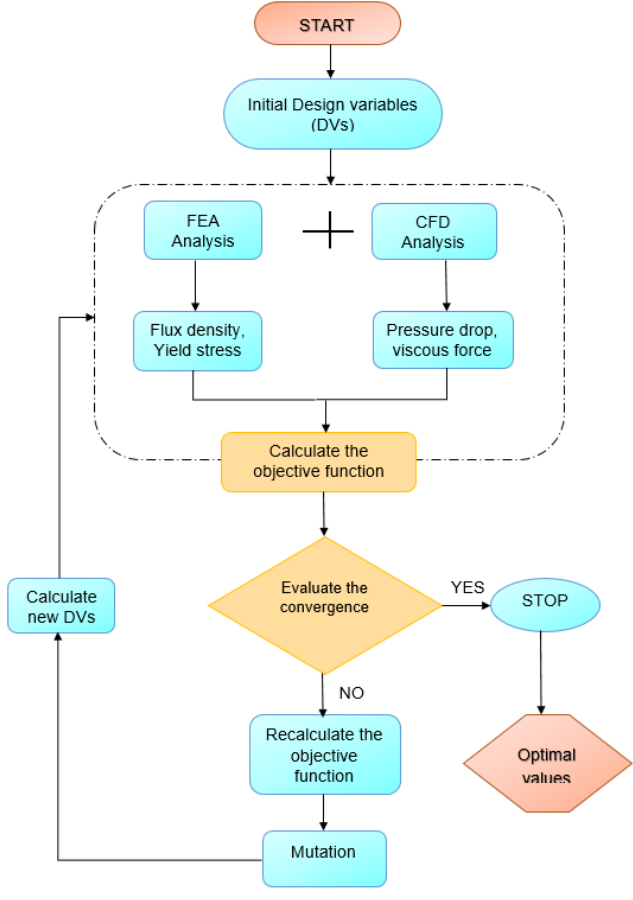
Table 2. Lower and upper bounds of design variables.